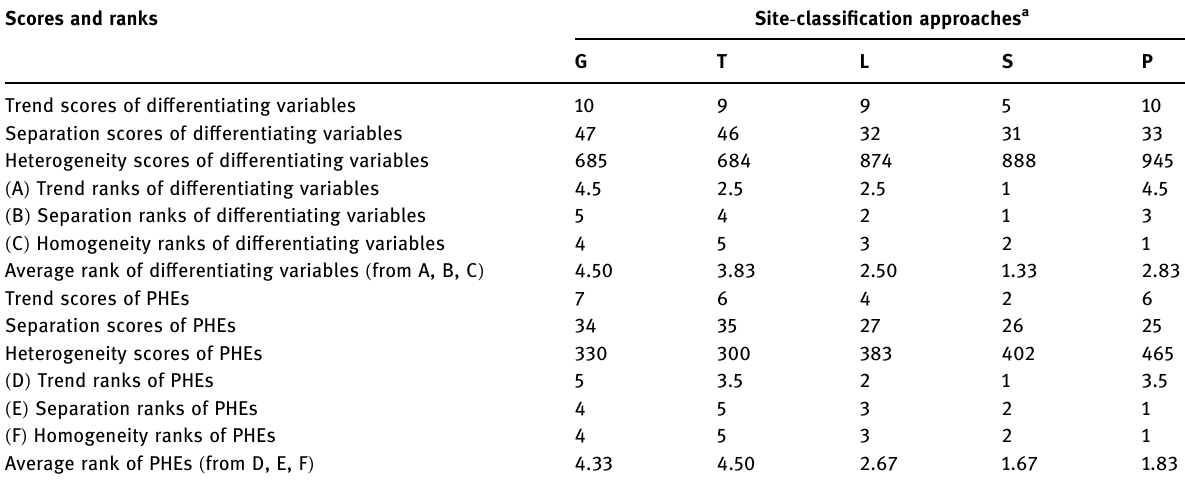
Table 7: Scores determined using ten di ff erentiating variables and seven PHEs, and evaluation of the quality of site - classi fi cation approaches according to the respective ranks Scores and